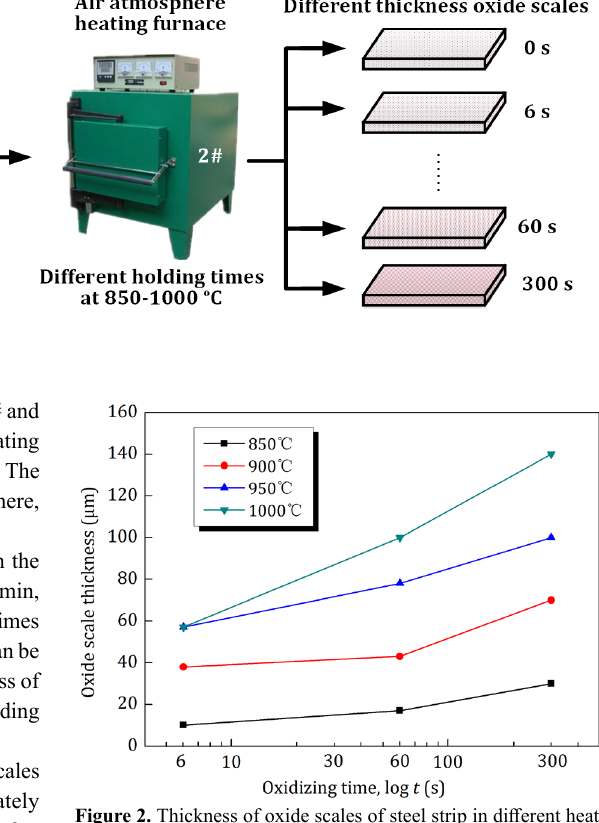
by choosing the different holding times for the different heat temperatures. The predefined holding times and thickness of oxide scales for the different heat temperatures are shown in Table 2. The critical thickness of oxide scale before rolling process is the critical points of promotion and inhibition oxide scale of steel strip.